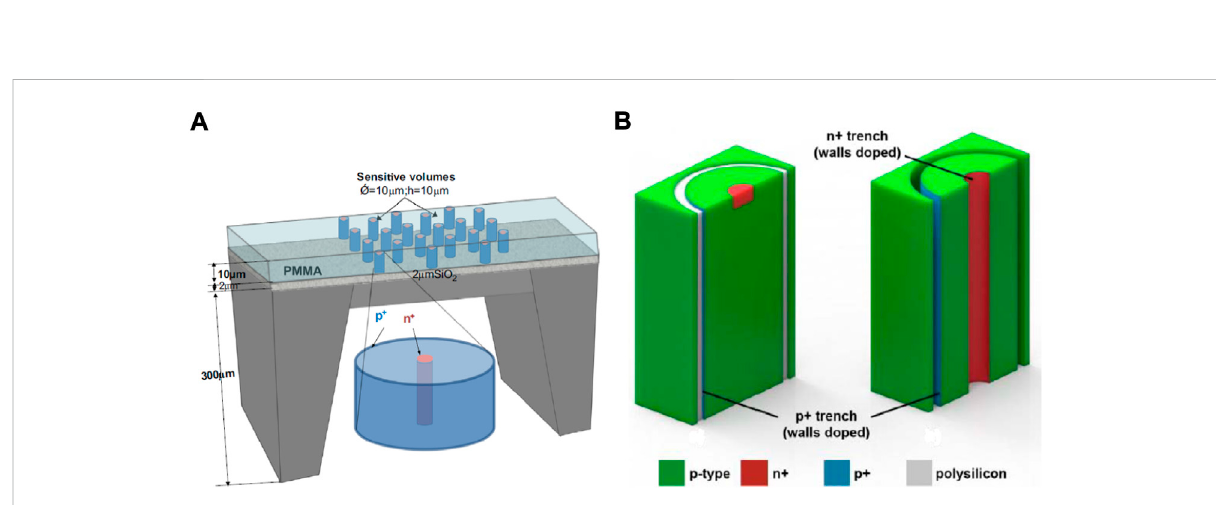
FIGURE 8 Schematic of the mushroom microdosimeter and of its sensitive volumes structure. (A) Schematic of the mushroom microdosimeter design. Source: [69]. (B) Schematics of two different con fi gurations designed to de fi ne the sensitive volumes geometry and charge collection properties: a trenched planar structure on the left, and a Trenched 3-D structure on the right. Source: